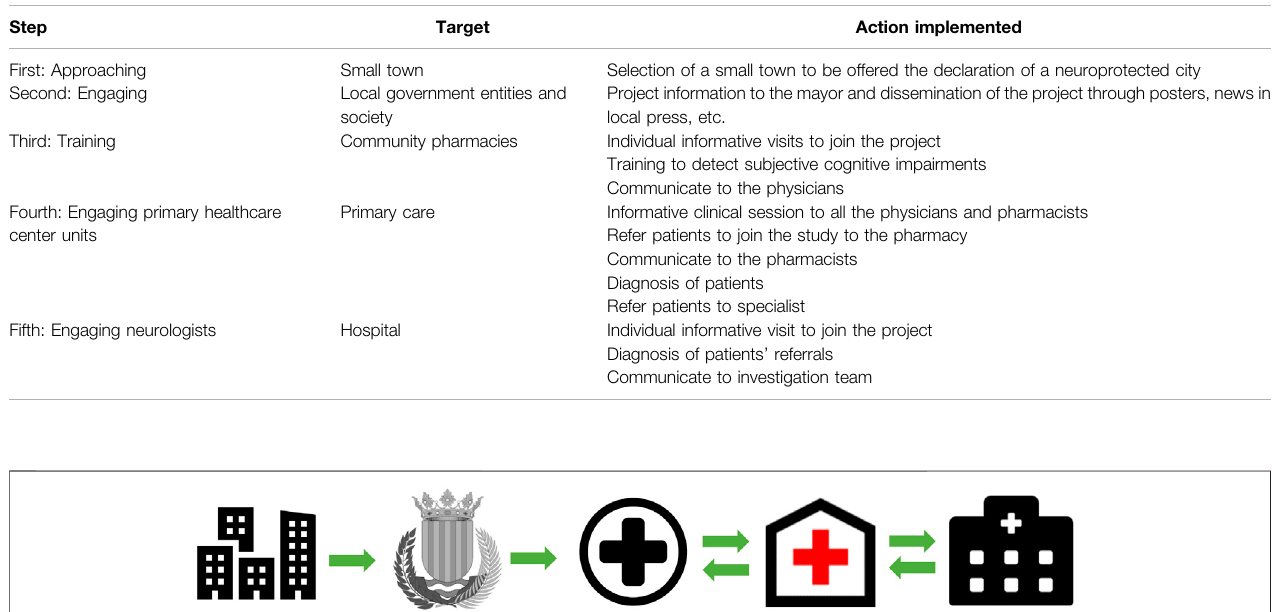
TABLE 1 | Five steps of the IPC group protocol.